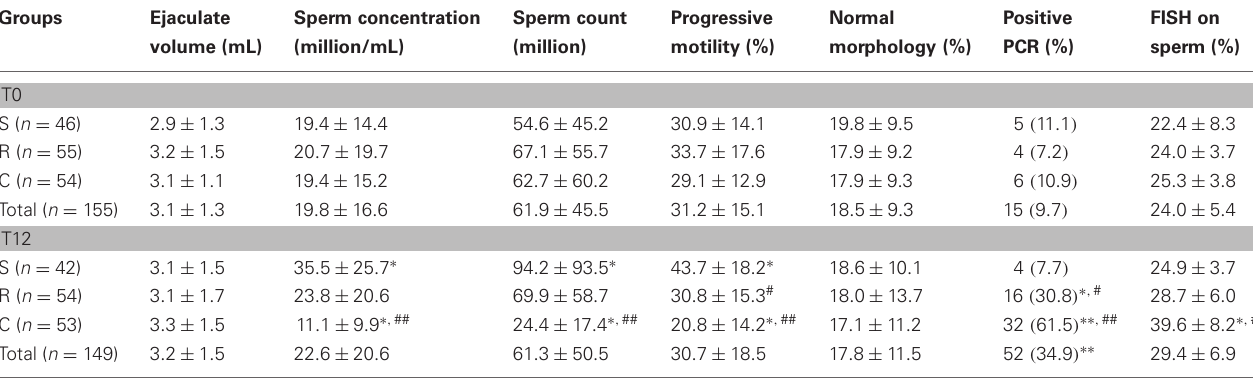
Table 2 | Sperm parameters, HPV DNA detection and FISH for HPV observed in testicular cancer patients 1 month after orchiectomy (T0) and after 12 months (T12) from the end of any